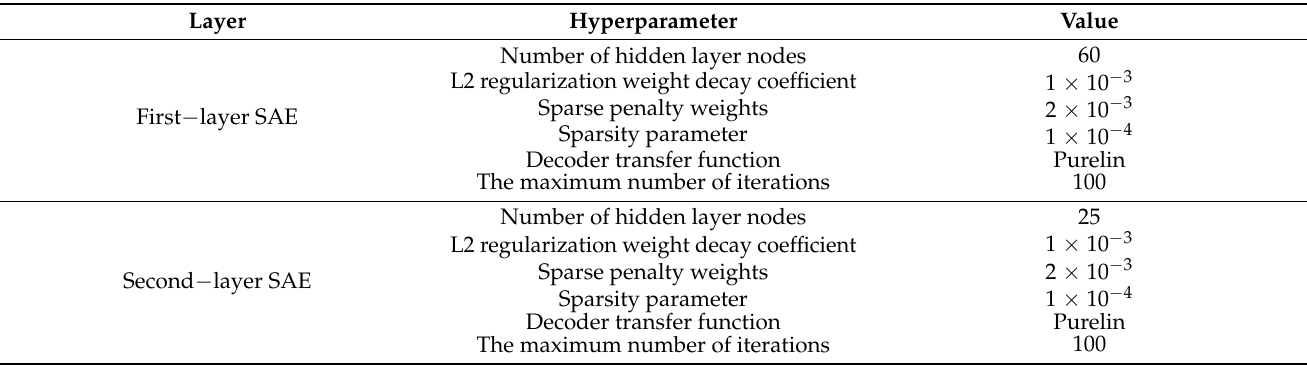
Table 6. Hyperparameter settings of SSAE.